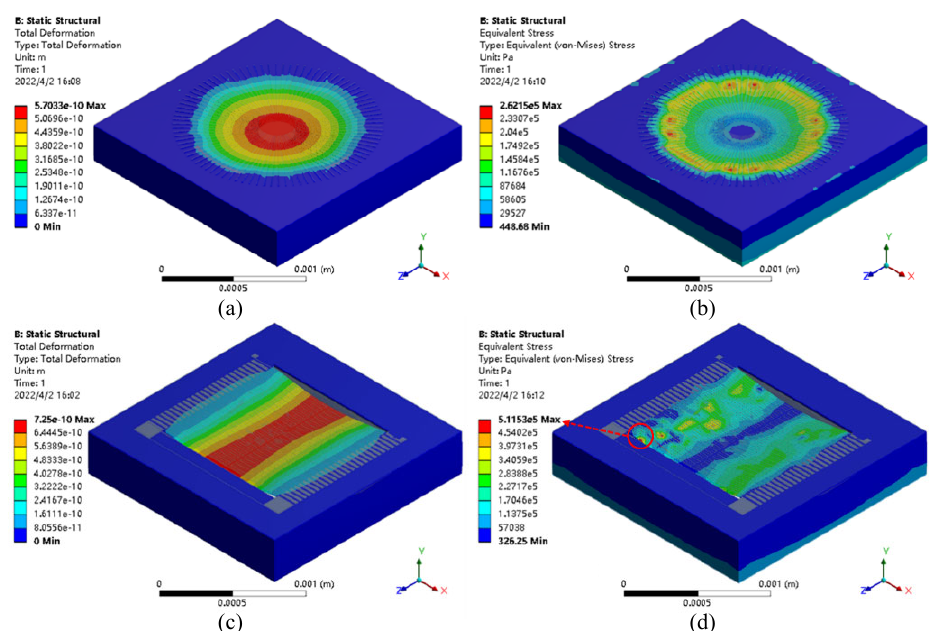
Fig. 7 ANSYS finite element simulation of the circular thermopile and the double-ended symmetrical rectangular thermopile: (a) the simulated deformation shape of the circular thermopile, (b) the simulated stress intensity of the circular thermopile, (c) the simulated deformation shape of the double-ended symmetrical rectangular thermopile, and (d) the simulated stress intensity of the double-ended symmetrical rectangular